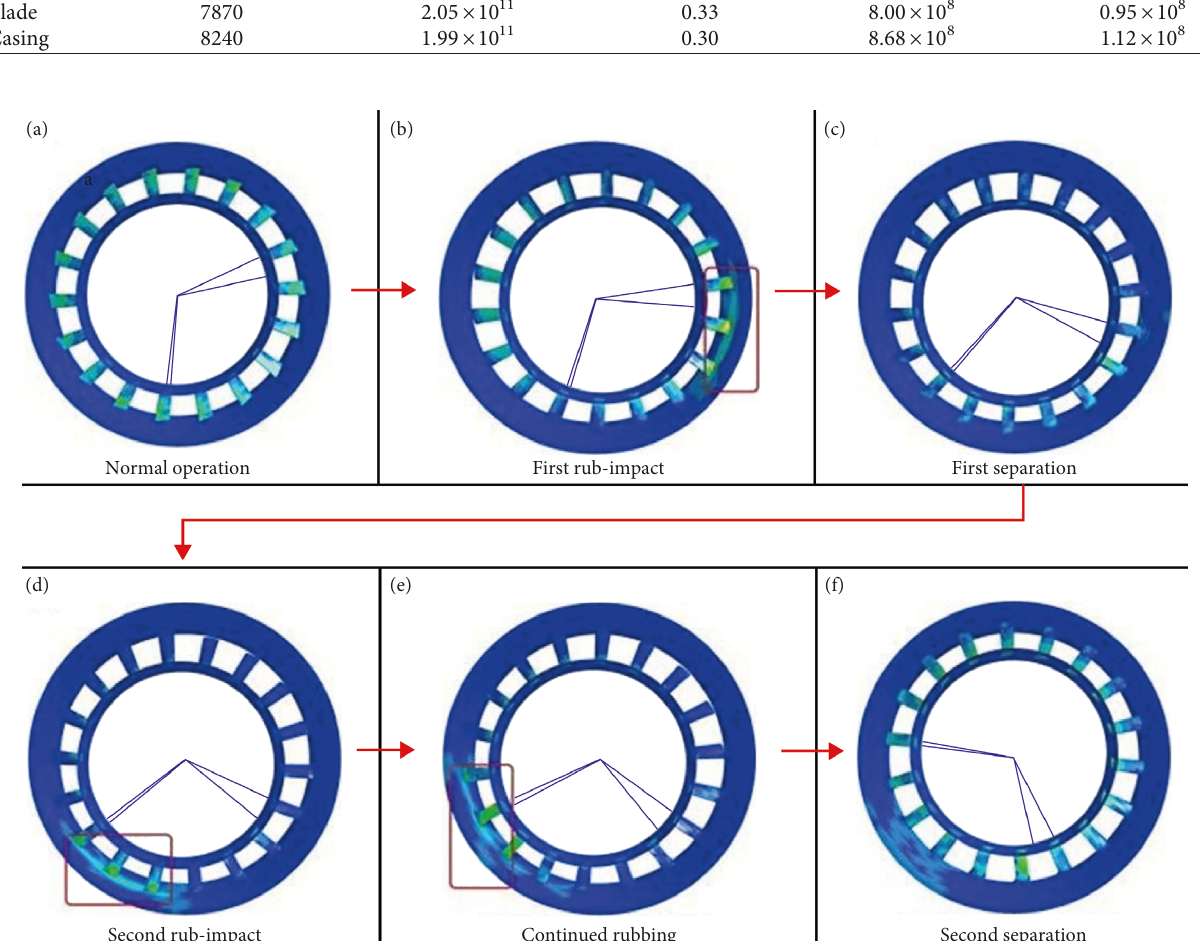
Figure 16: Rub-impact process during 2000 μ s shown in Von Mises stress.